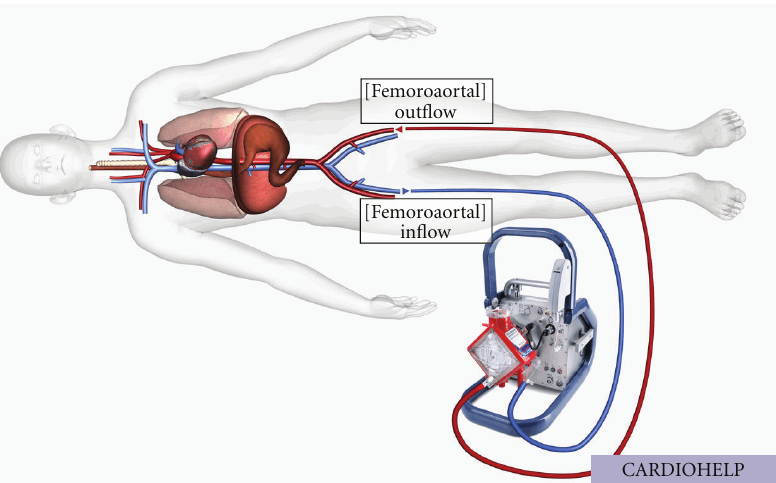
Figure 4: Example of extracorporeal life support (ECLS). CARDIOHELP System (MAQUET, Cardiopulmonary AG, Germany). Minimised hand-held ECLS with representation of a femorofemoral, venoarterial cannulation. Deoxygenated blood is harvested in the femoral vein and pumped back to the iliac artery after having passed through the oxygenating membrane and the heat